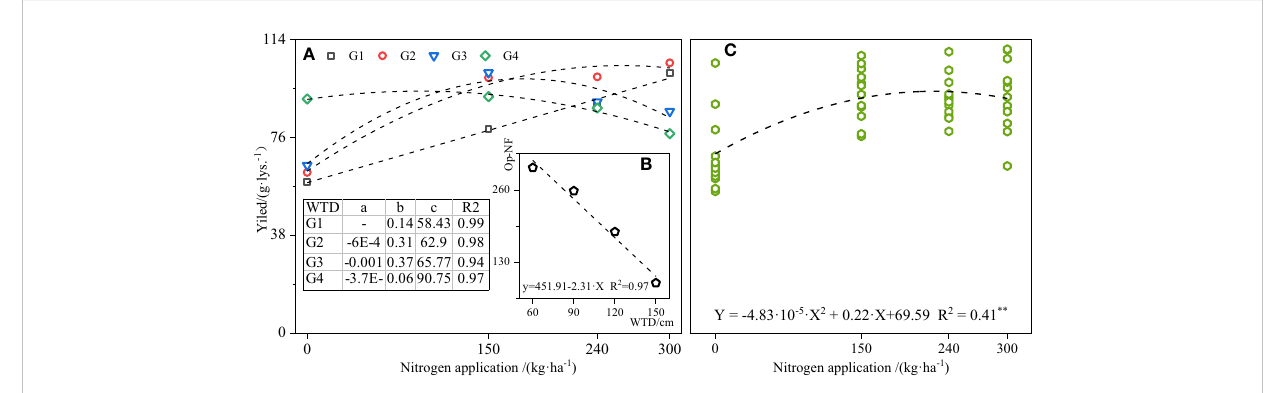
FIGURE 7 Fitting analysis of appropriate N application rate based on yield. In (A) , a is a quadratic coef fi cient, b is a linear coef fi cient, c is a constant term, and ** means P < 0.01.